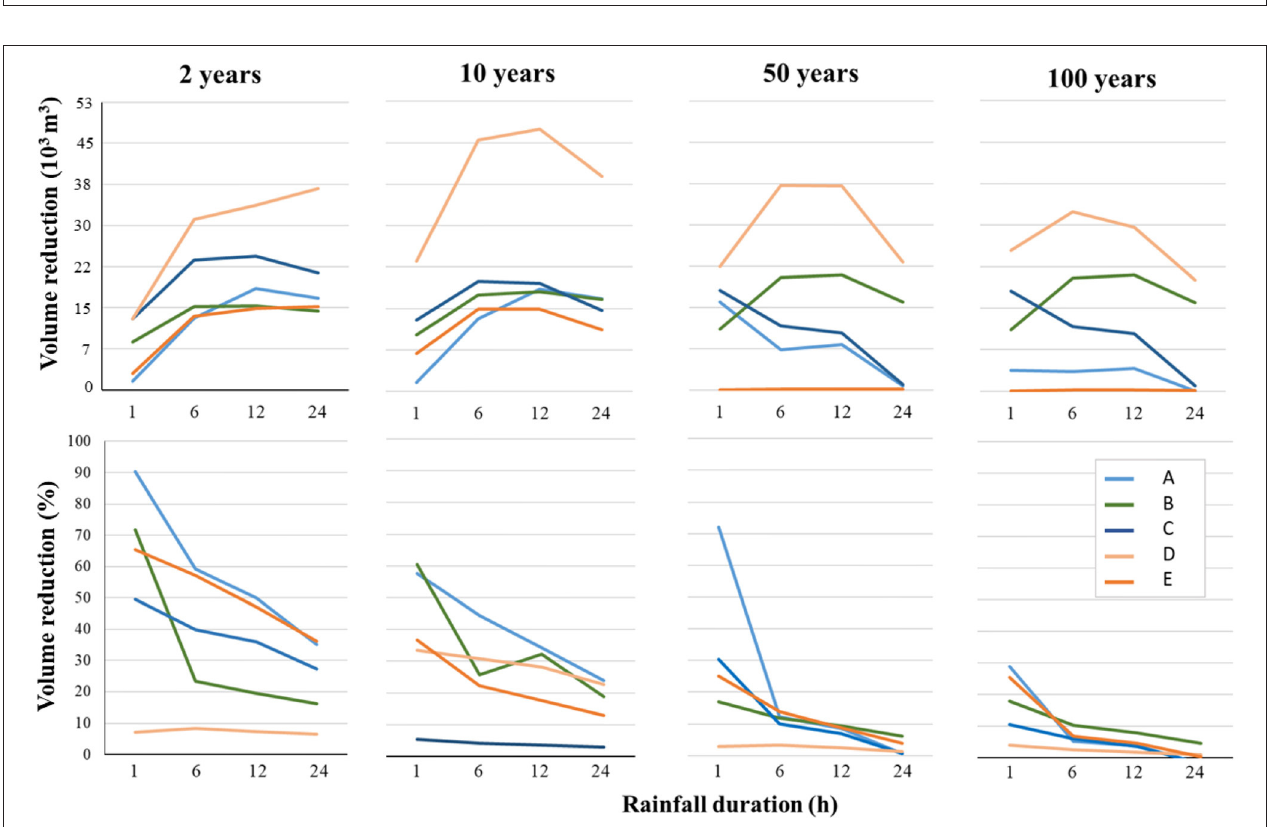
FIGURE 6 | Volume (thousand m 3 ) reductions when porous pavements are placed in all parking lots for the five prioritized CSO outfalls using the timeframe 1970–1999.